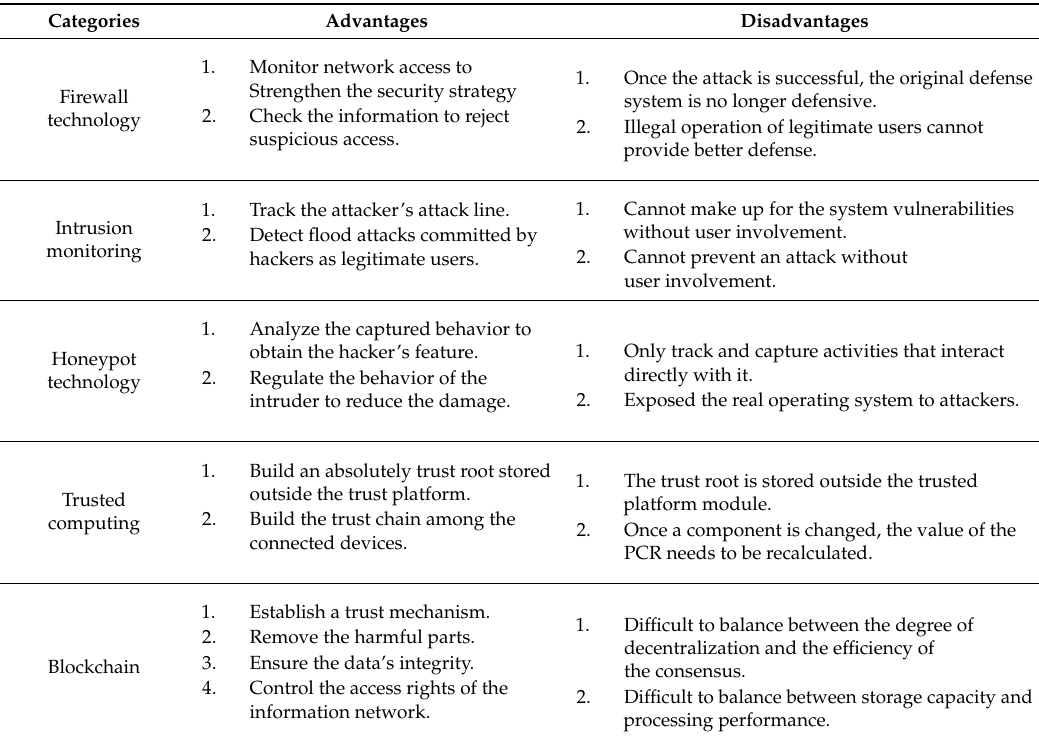
Table 3. Advantages and disadvantages of proactive defense, passive defense and the